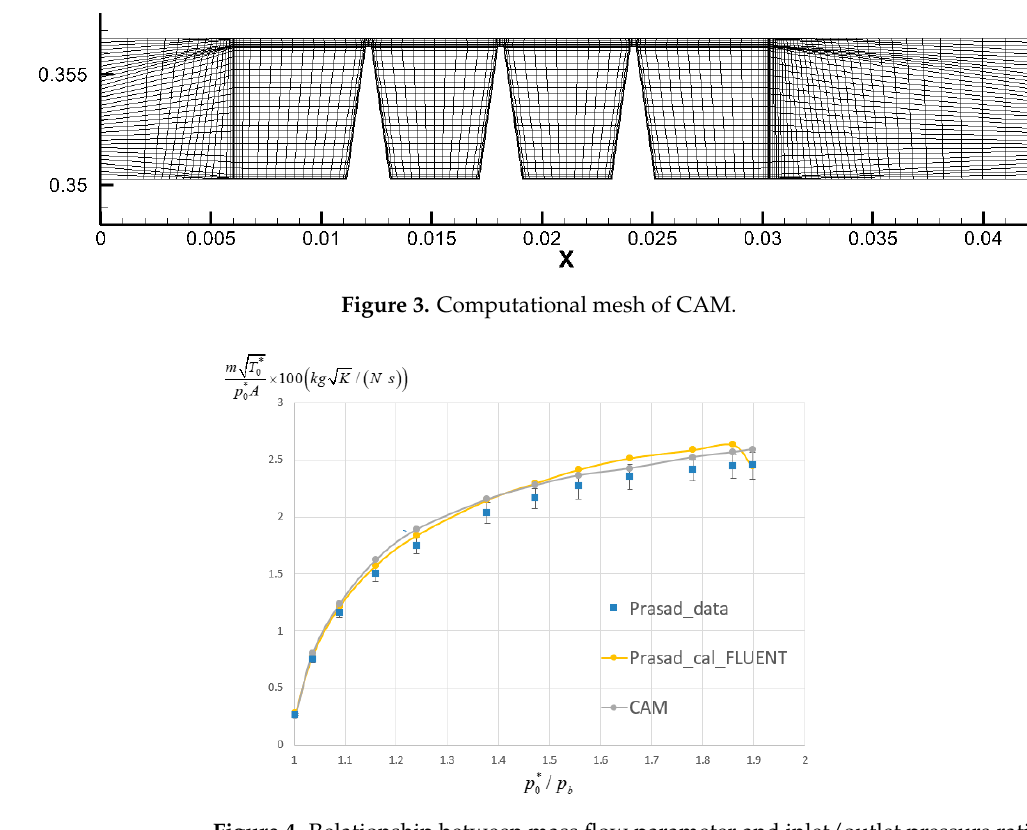
Figure 4. Relationship between mass flow parameter and inlet/outlet pressure ratio.